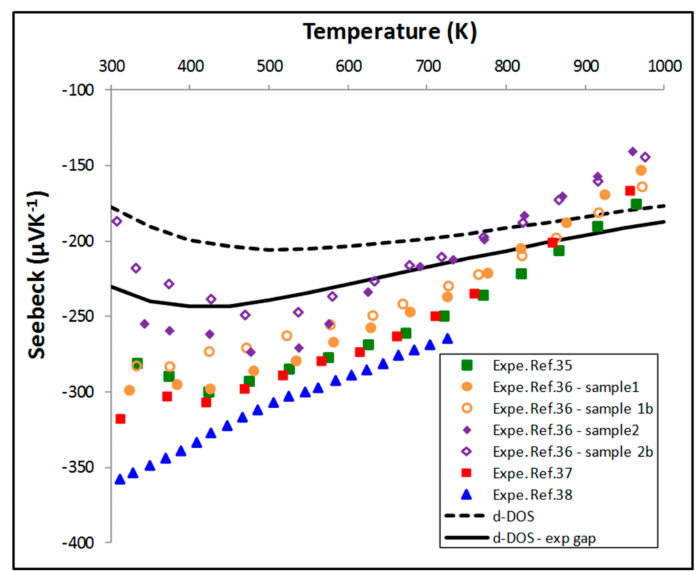
Figure 5. Evolution of the Seebeck coefficient calculated using BoltzTraP compared to a selection of experimental